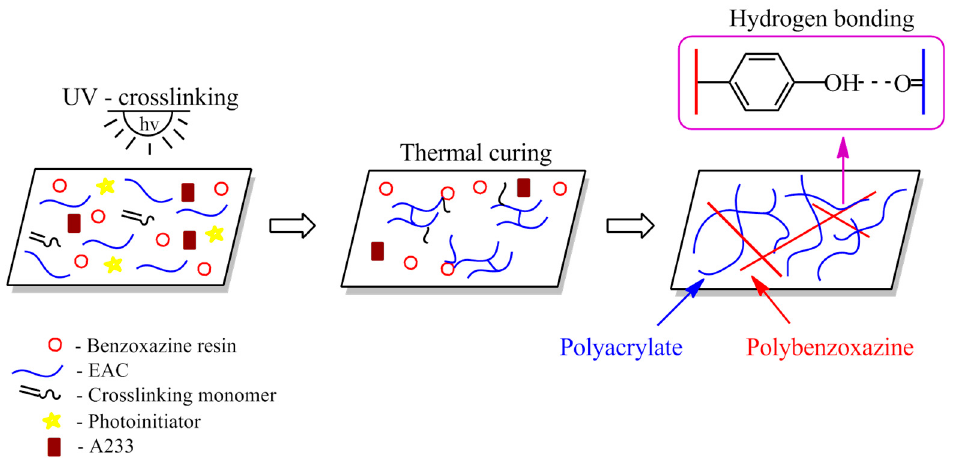
Figure 8. Preparation steps of UV-cross-linked SATs and thermally cured SATs (Al/SAT/Al joints). UV-cross-linked SATs were applied between aluminum panels and thermally cured at 180 °C for 60 min. Overlap shear strength ( τ ) values recorded for thermally cured Al/SAT/Al joints are presented in Figure 9.